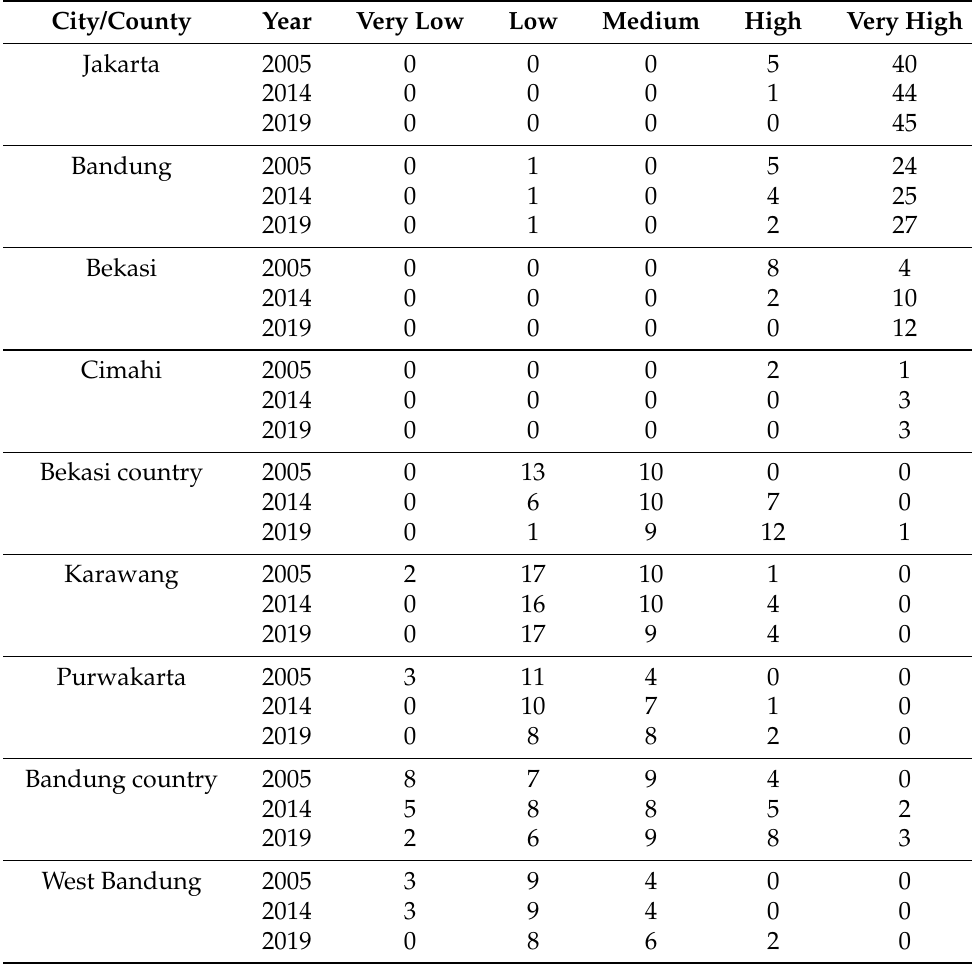
Table A9. Number of subdistricts at each heat wave risk level based on city/county.